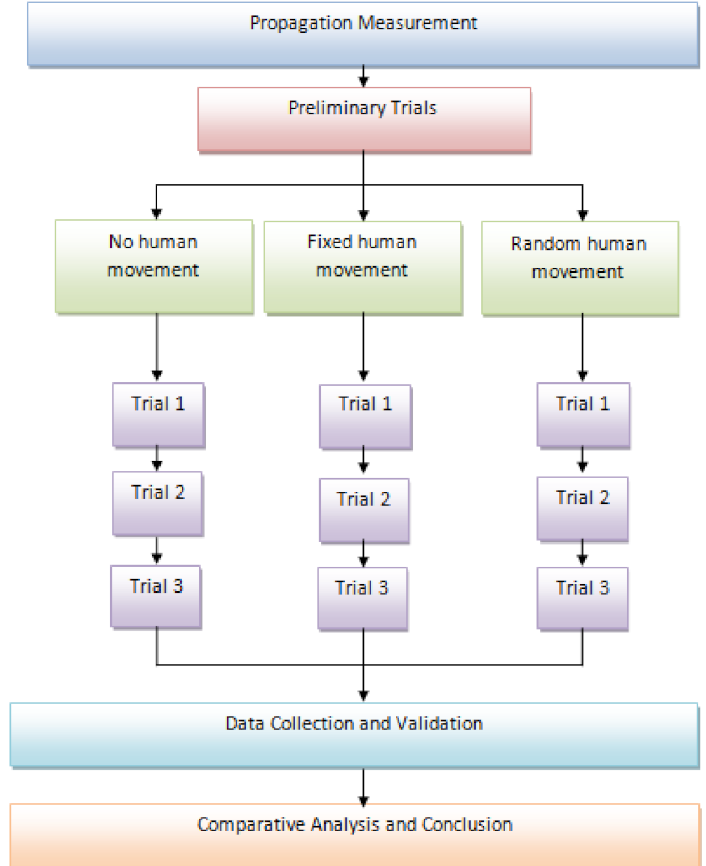
Figure 1. Research methodology